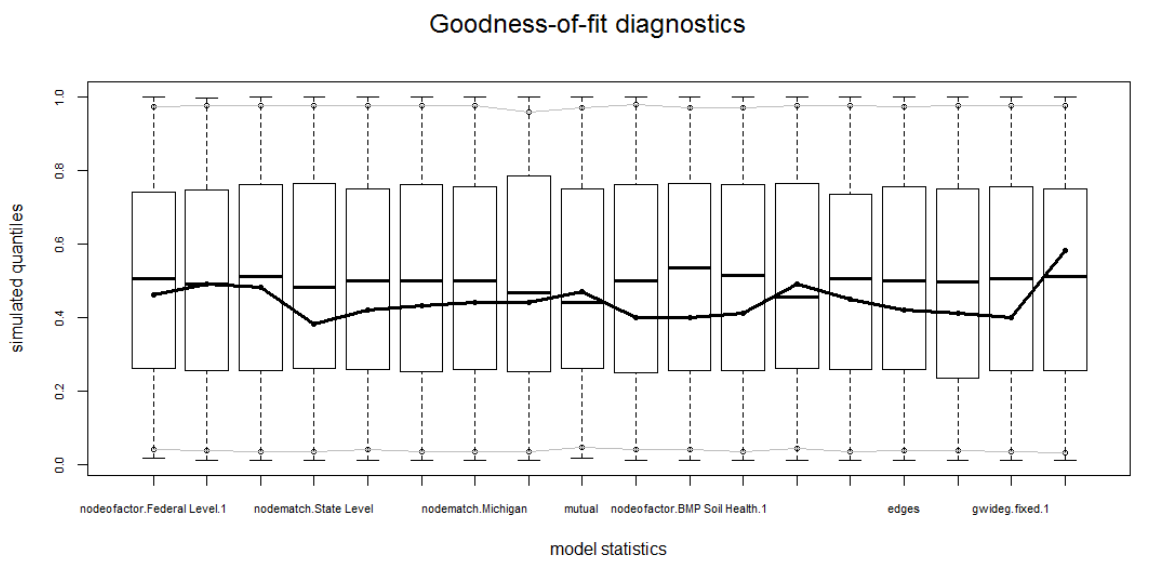
Figure A1.1. Diagnostics for Model Statistics